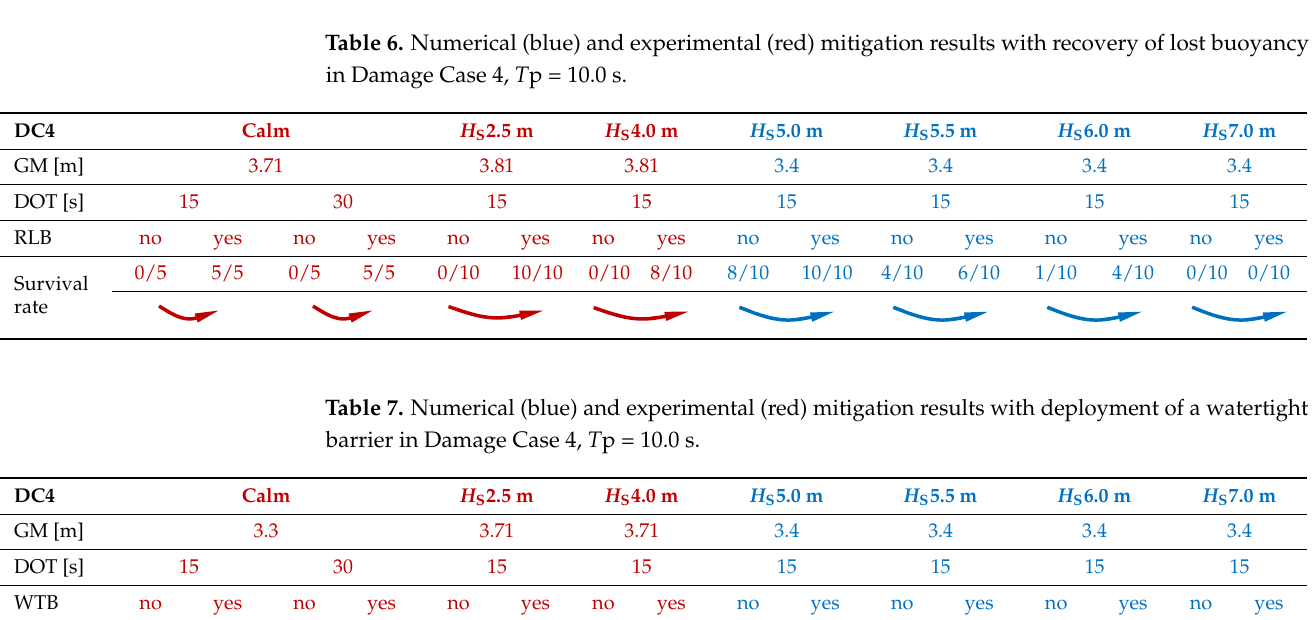
Table 7. Numerical (blue) and experimental (red) mitigation results with deployment of a water ‐ tight barrier in Damage Case 4, T p = 10.0 s. Table 6. Numerical (blue) and experimental (red) mitigation results with recovery of lost buoyancy in Damage Case 4, T p = 10.0 s.